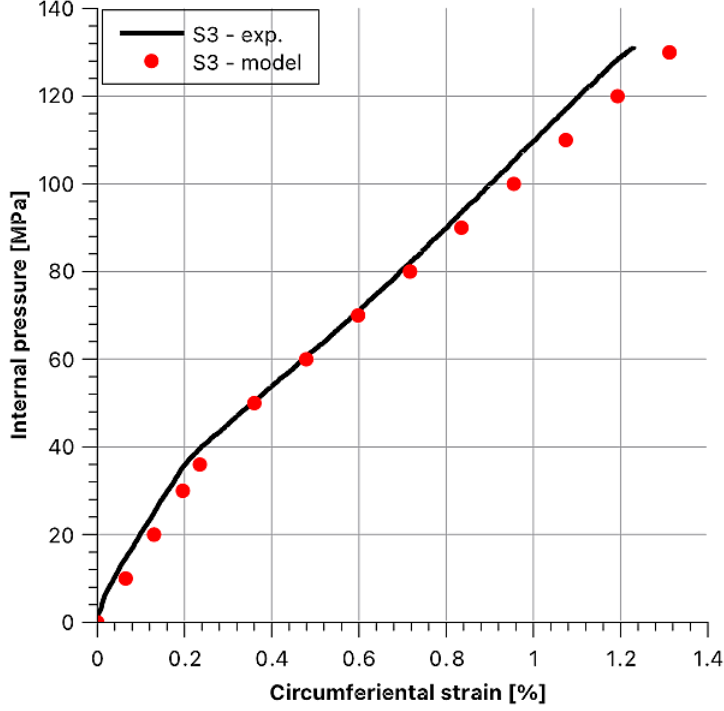
Figure 22. Stress and strain results as a function of internal pressure for sample S3.